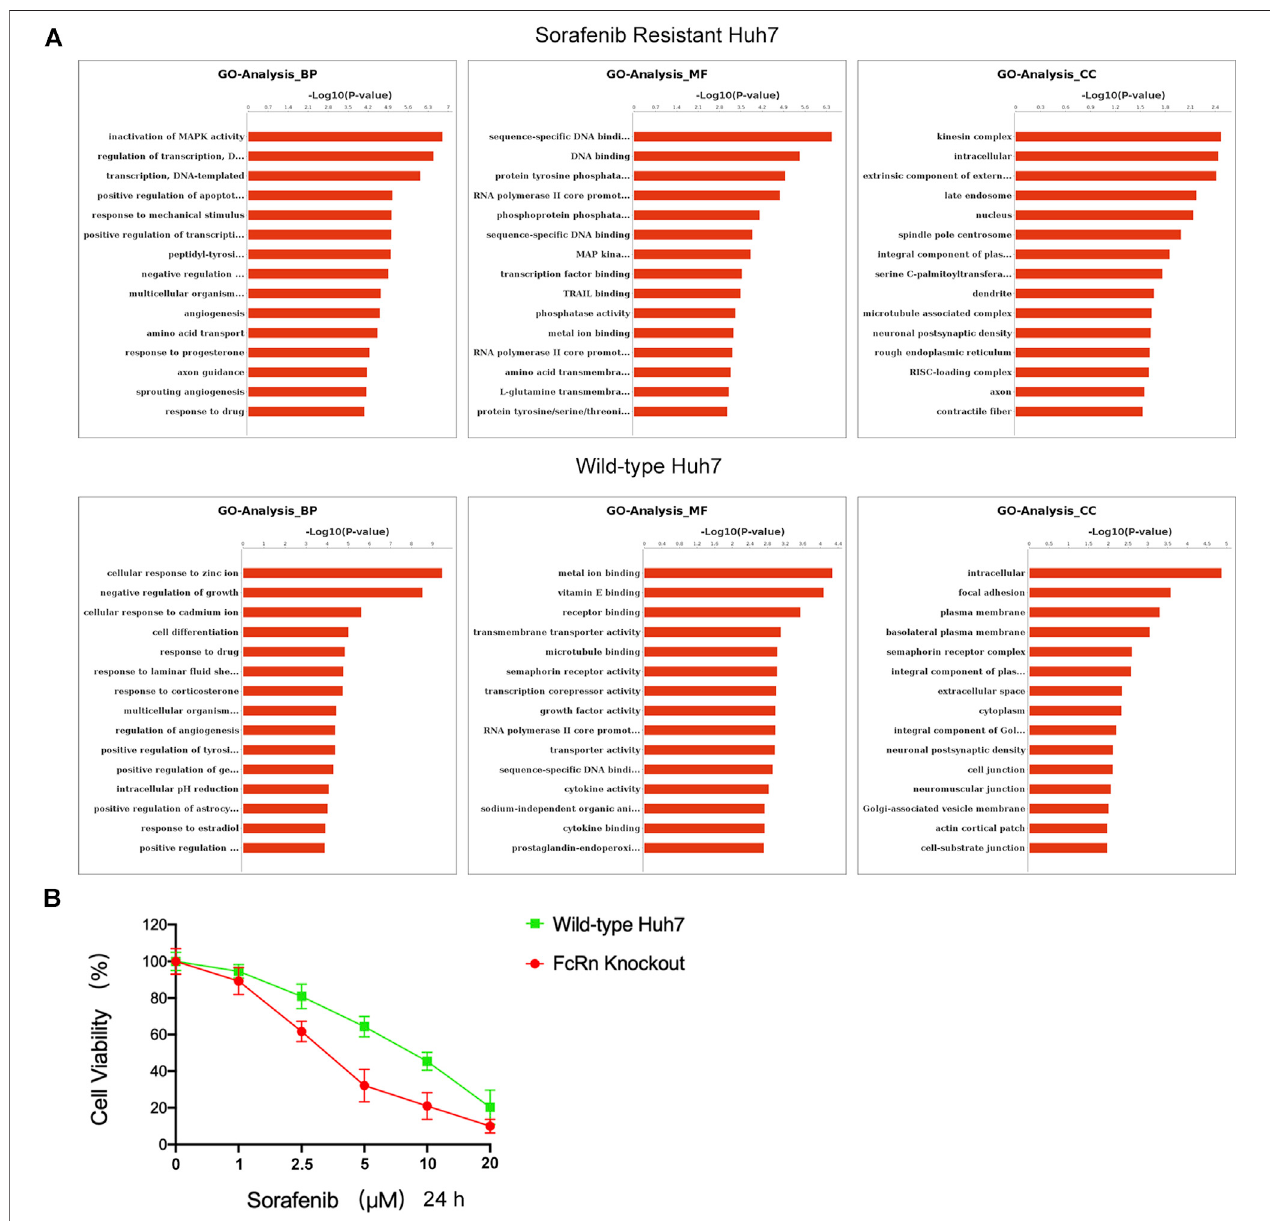
FIGURE 6 | ALB-FcRn interaction caused the proliferation of sorafenib-resistant cells. (A) GO analysis of Huh7 (SR) and Huh7 (WT) cells which were added ALB after serum starvation 6 h by RNA-seq. (B) Huh7(WT) and Huh7(KO) were cultured with increasing doses of sorafenib (0 – 20 μ M) for 24 h incubation. The percentage of surviving cells in relation to the controls was determined by